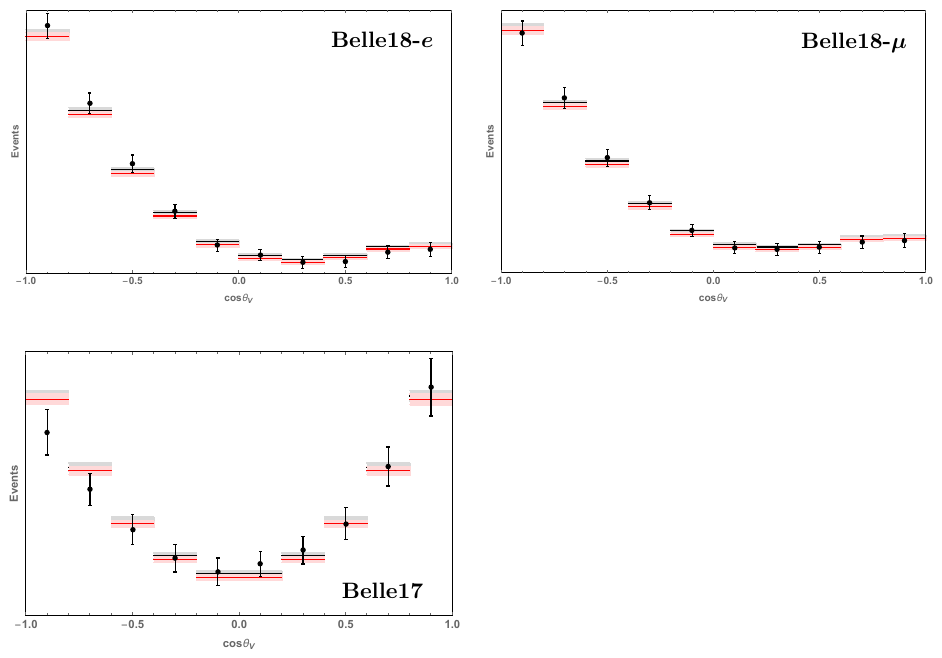
Figure 5 . Binned decay distributions of cos (cid:18) V . Conventions are the same as in (cid:12)gure 3.